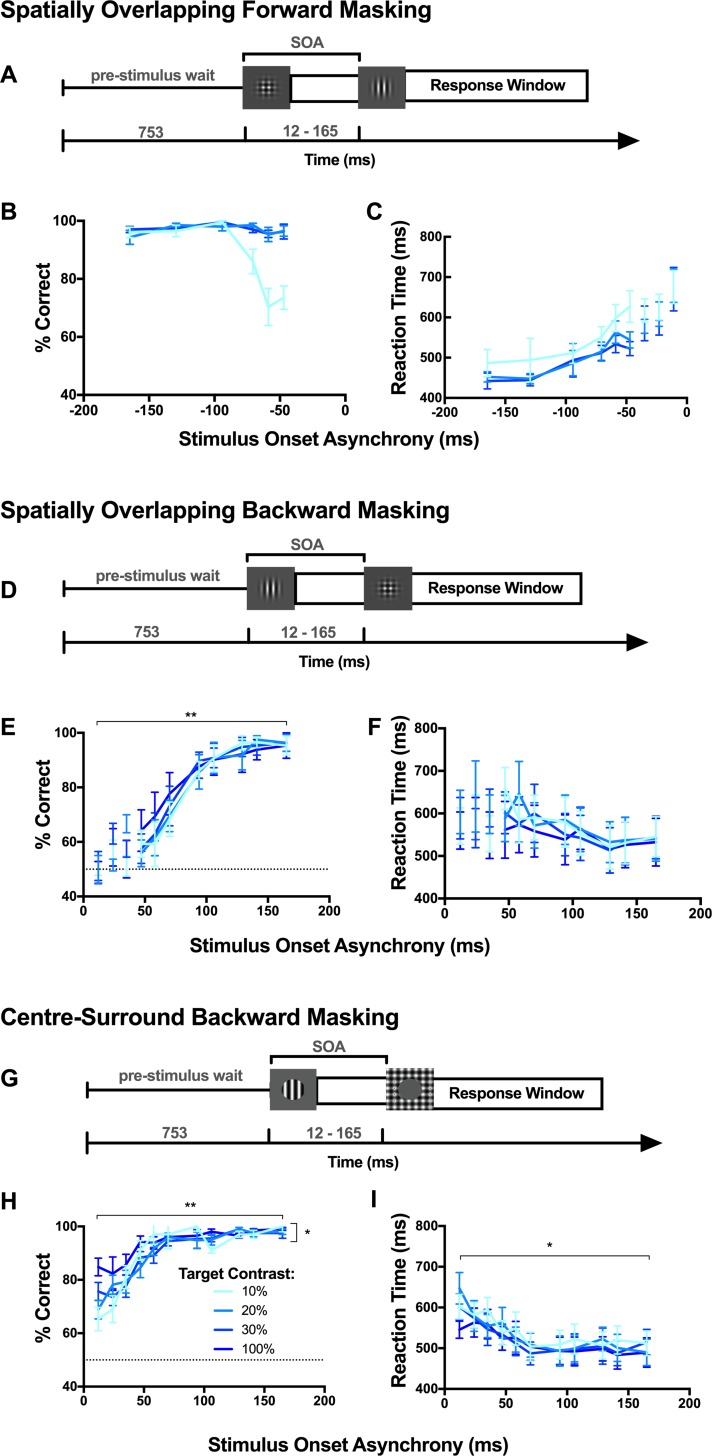
Human orientation discrimination and reaction times are influenced by mask stimuli at short stimulus onset asynchronies (SOAs).(A) Schematic of trial structure for spatially overlapping forward masking. (B) Orientation discrimination performance across six participants (mean, SE) for three target contrasts (10,20 and 30%). The dotted line represents chance performance. (C) Mean (SE) reaction times, measured from target onset until keypress response. Performance and reaction times for temporally overlapping SOAs, where the target duration was truncated, are presented separately from the remainder of the curve. (D-F) same as (A-C) for spatially overlapping backward masking. (G-I) Same as for (A-C) for centre-surround backward masking. (**) p<0.0001; (*) p<0.001.